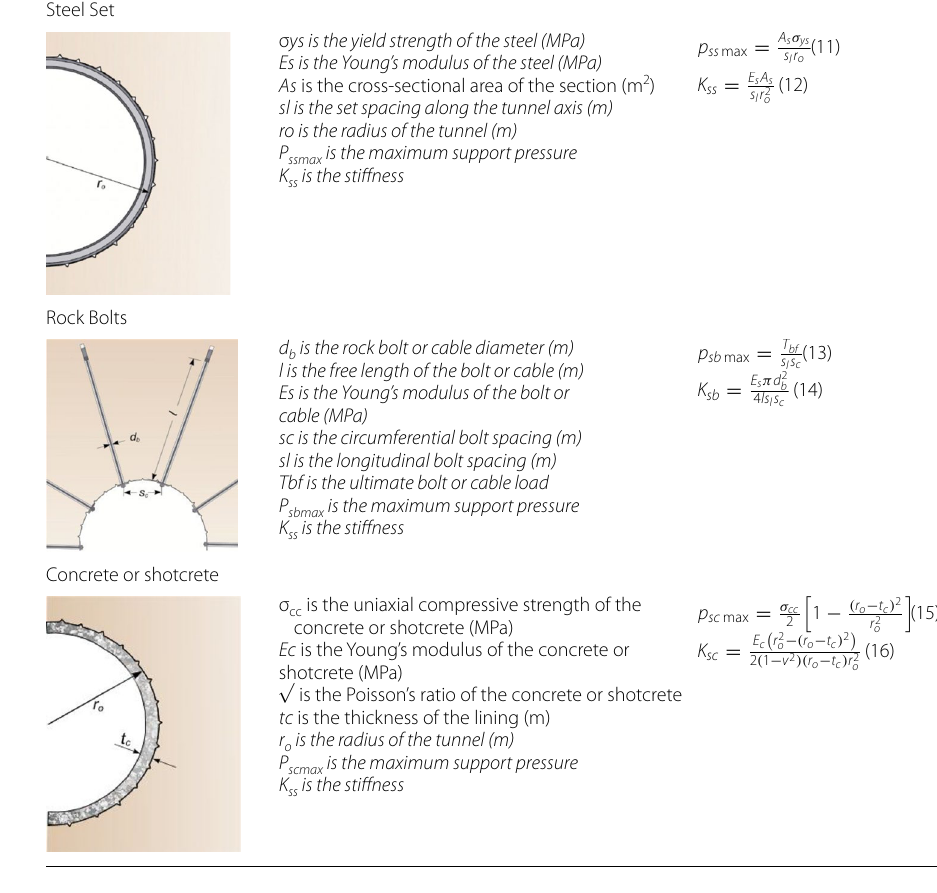
150 + d 32 mm, P ult 280 kN = =